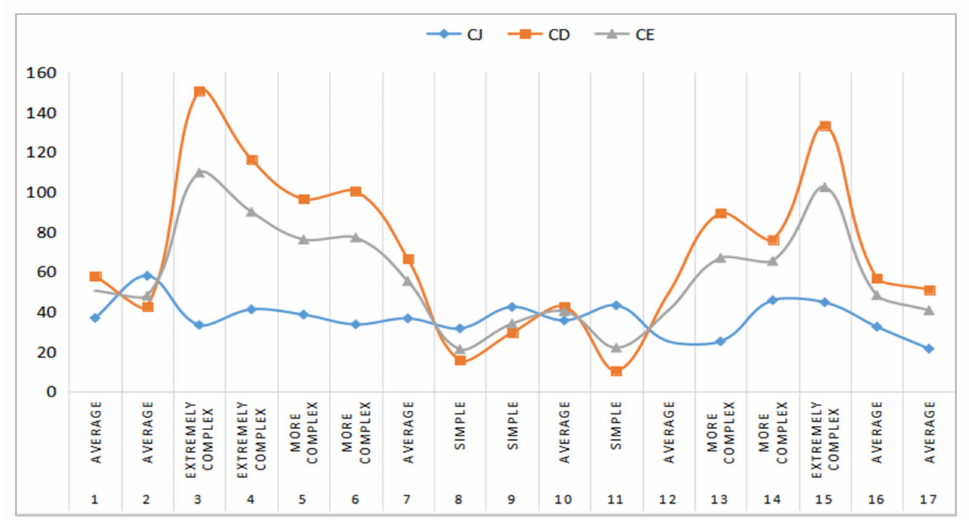
Figure 8. The complexity statistical analysis of static element complexity, dynamic element complexity, and comprehensive complexity.